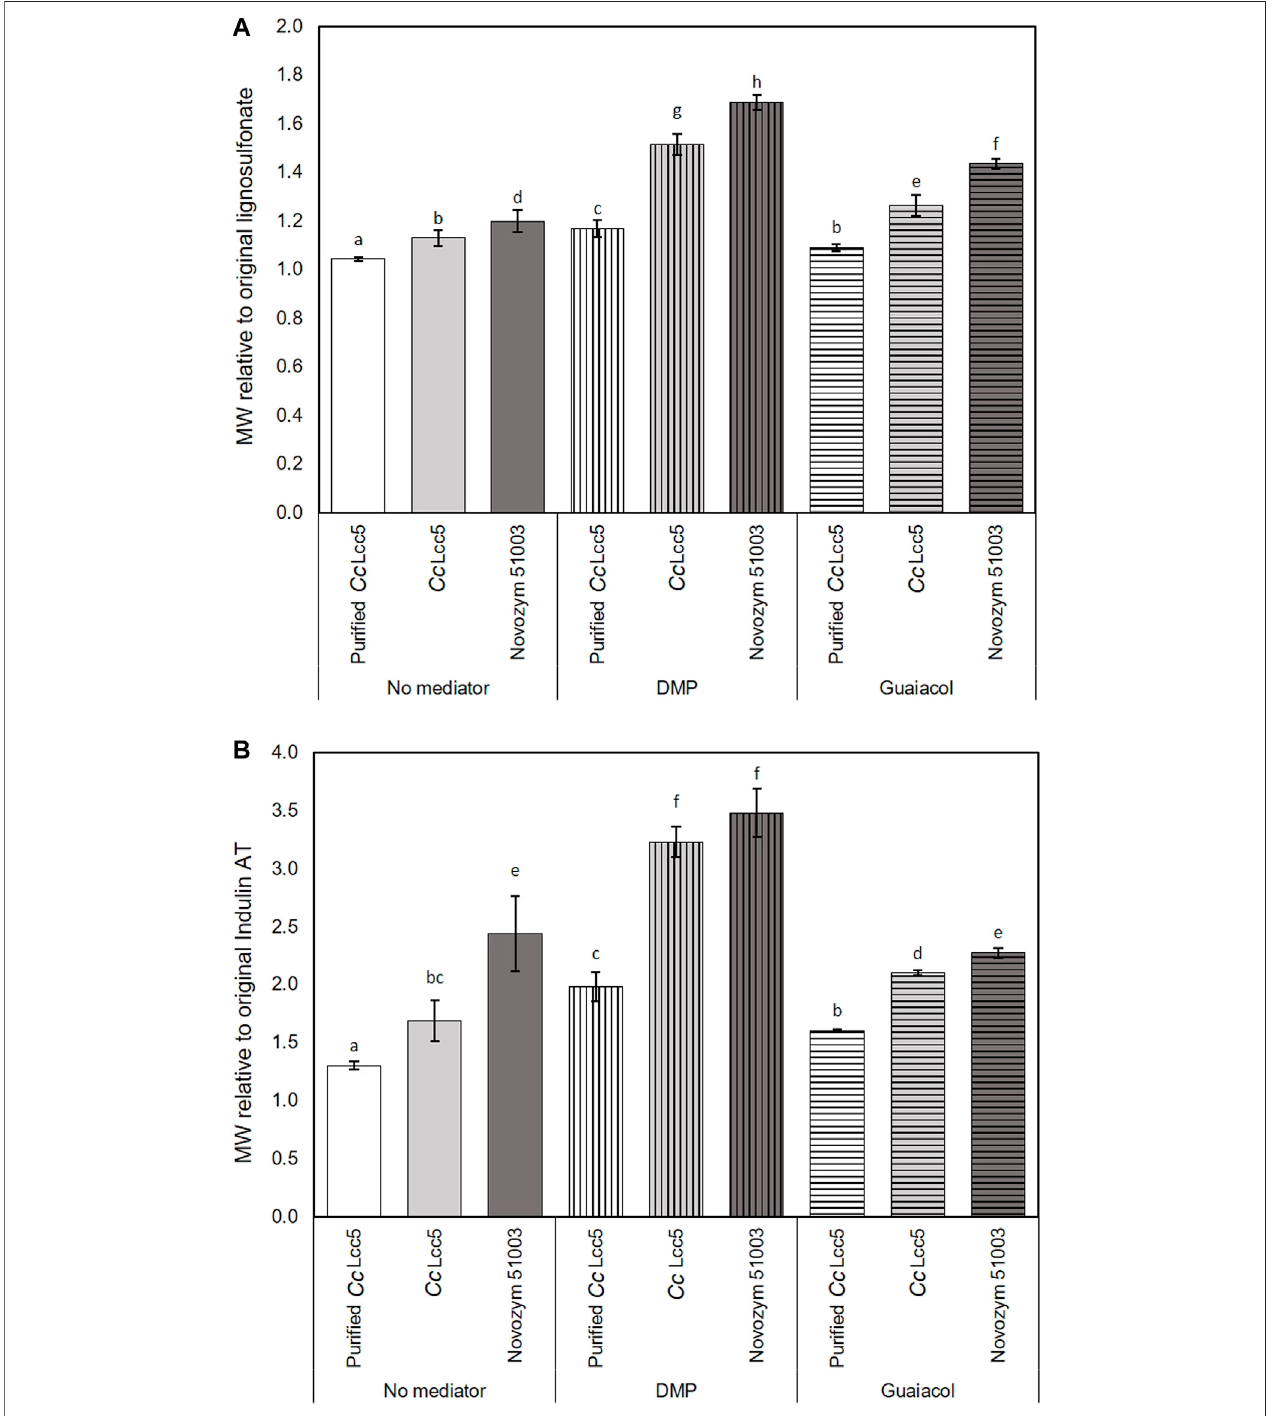
FIGURE2 | Relative increments in MWs oftechnical lignins, (A) lignosulfonate and (B) Indulin AT, by 30 min incubation with different laccasepreparations, puri fi ed and unpuri fi ed Cc Lcc5 and Novozym 51003, applied in samples without mediator and in LLMS with either DMP or guaiacol, as calculated from data presented in Table 1 . Different letters above bars ± SD ( n (cid:1) 3 samples) represent signi fi cant differences ( p > 0.05) in relative increase of MWs compared to the original MW of lignosulfonate and Indulin AT.